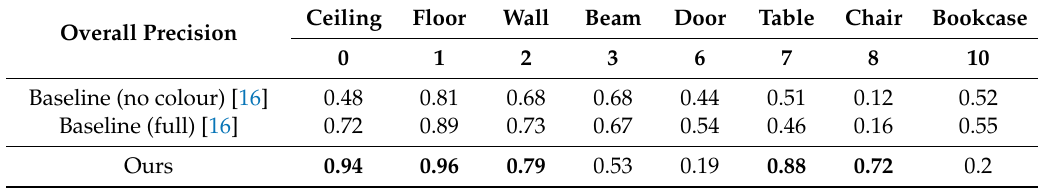
Table 12. Overall precision on the full S3DIS dataset against non-machine learning baselines.